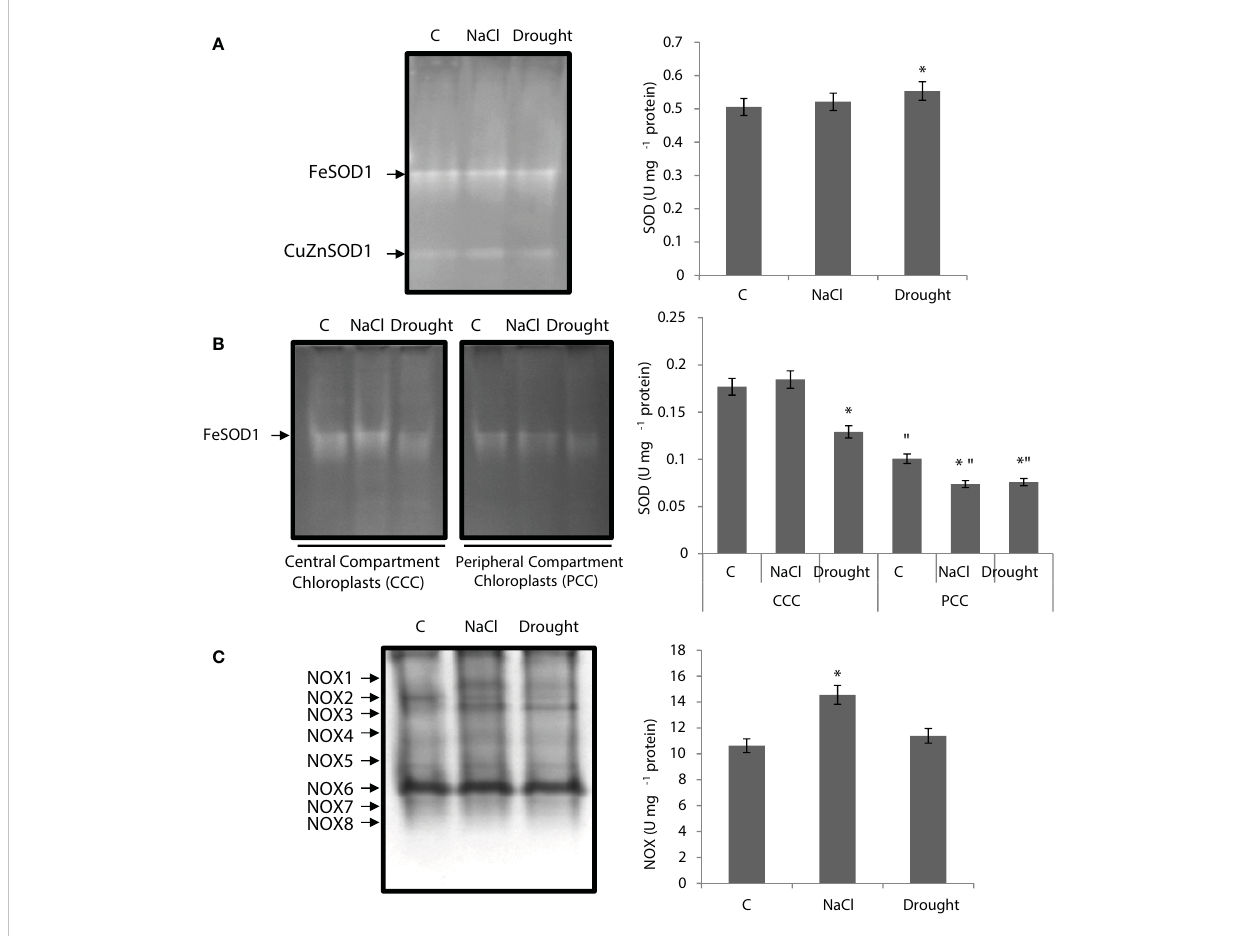
FIGURE 4 (A) Superoxide dismutase (SOD) native activity gel and total SOD activity of whole leaves. (B) SOD native activity gels and SOD activity of CCC and PCC. (C) NADPH oxidase (NOX) native activity gel and total NOX activity of whole leaves of Bienertia sinuspersici treated with 400 mM NaCl or water withholding for 10 d. “ * ” indicates signi fi cant difference (p < 0.05) as compared to controls. For CCC and PCC groups are compared to their own controls. When effects of treatments are compared between CCC and PCC, signi fi cant differences are shown with “